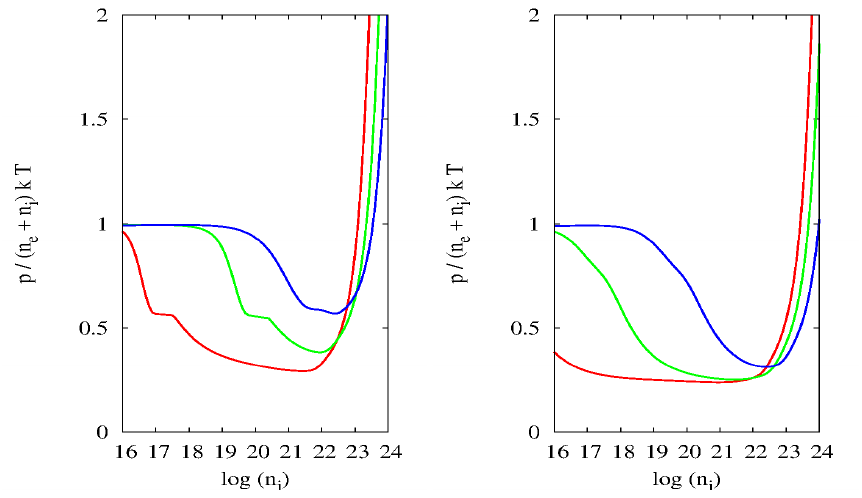
Figure 7. Helium and Lithium plasmas: Low and high-density approximations are concatenated by complementary tanh( x ) functions at the crossing point. Left panel: Helium plasmas at 30,000 K (red), 50,000 K (green) and 80,000 K (blue curve) as functions of the total ion density. Right panel: Lithium plasmas at temperatures 80,000 K (red), 120,000 K (green), 200,000 K (blue). The minima are due to the formation of bound